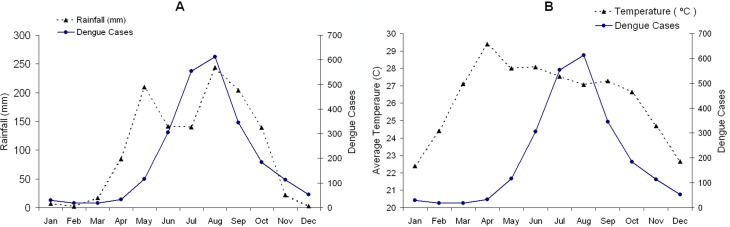
The average monthly incidence rate of dengue during 2004–2014 in Chiang Mai, Thailand is indicated by the complete line.The broken lines are (A) the average monthly rainfall and (B) the mean temperature during the same period.